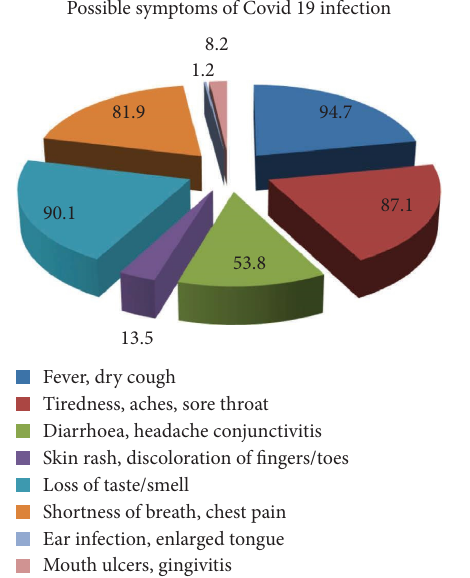
Figure 1: Percentage of each response as marked by the residents when asked about the possible symptoms of COVID-19 infection.